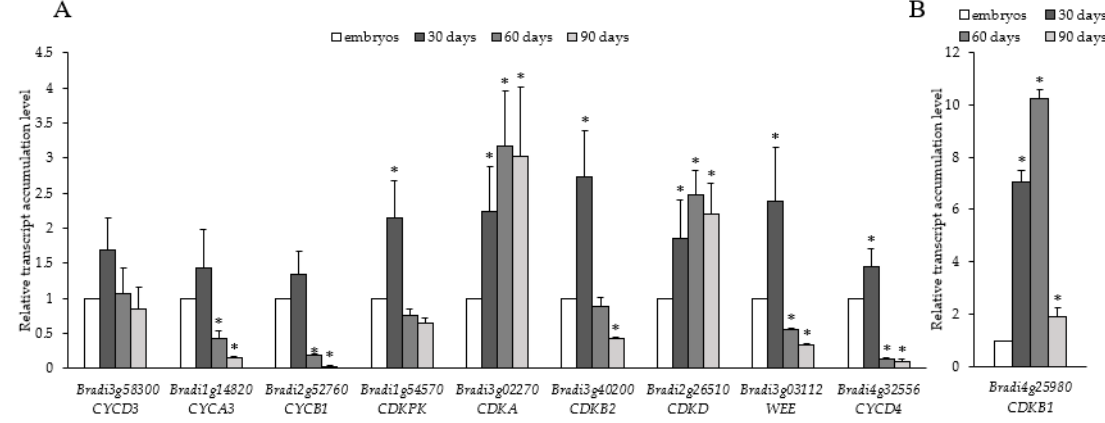
Figure 6. Relative transcript accumulation levels of ( A ) CYCD3 ( Bradi3g58300 ), CYCA3 ( Bradi1g14820 ), CYCB1 ( Bradi2g52760 ), CDKPK ( Bradi1g54570 ), CDKA ( Bradi3g02270 ), CDKB2 ( Bradi3g40200 ), CDKD ( Bradi2g26510 ), WEE ( Bradi3g03112 ), and CYCD4 ( Bradi4g32556 ), and ( B ) CDKB1 ( Bradi4g25980 ) on the 30th, 60th and 90th day of culture. The relative transcript accumulation levels were normalised to an internal control ( AK437296 , gene encoding ubiquitin) and calibrated to the control (explants, zygotic embryos); *: value is significantly different from the control (Student’s t -test, p < 0.05; n = 3 ±